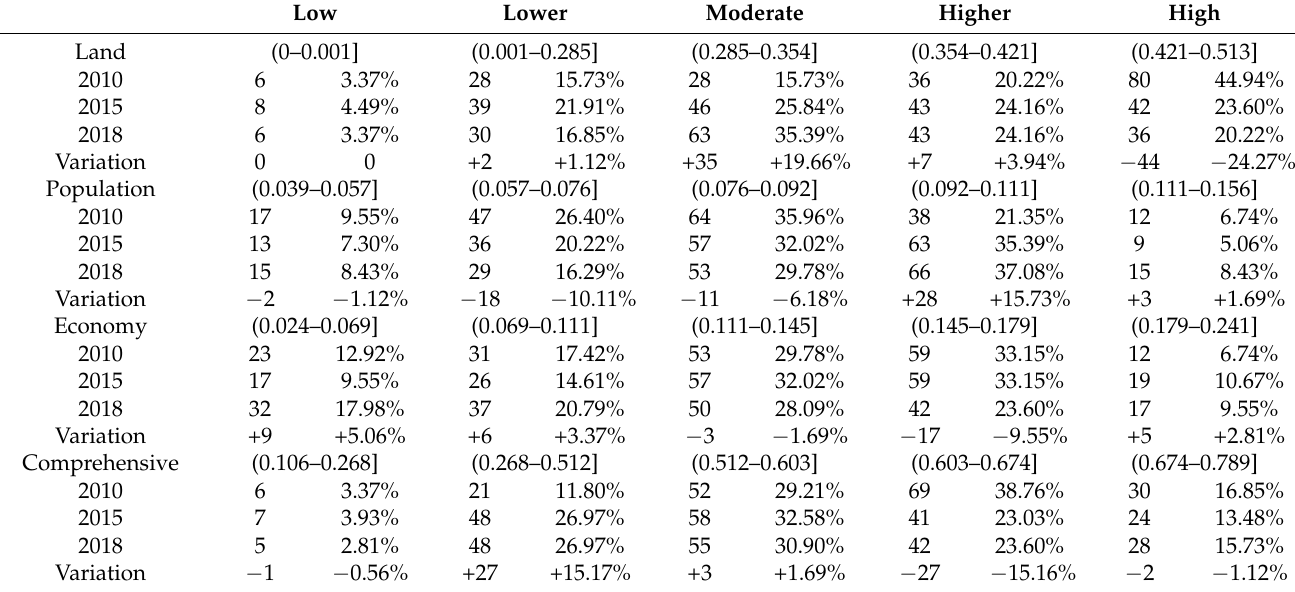
Table 5. Variation in the amount of rural hollowing at different